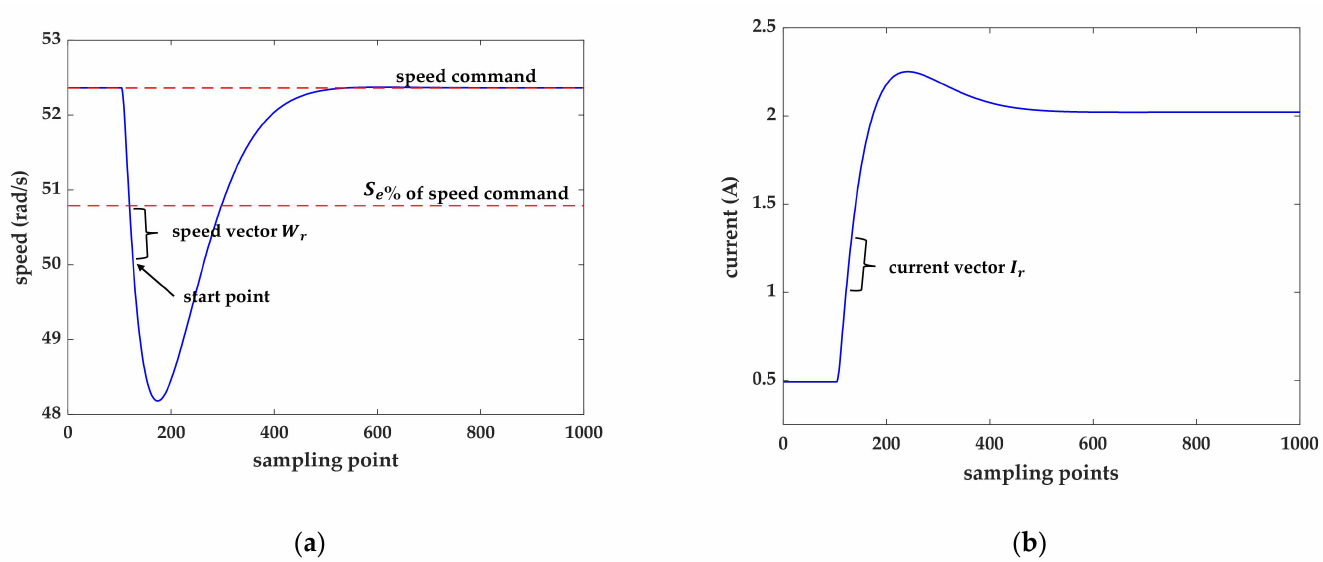
Figure 6. Signals fed into the actor network under the conditions of speed command 52.359 rad/s and load disturbance 0.717 Nm: ( a ) speed and ( b )